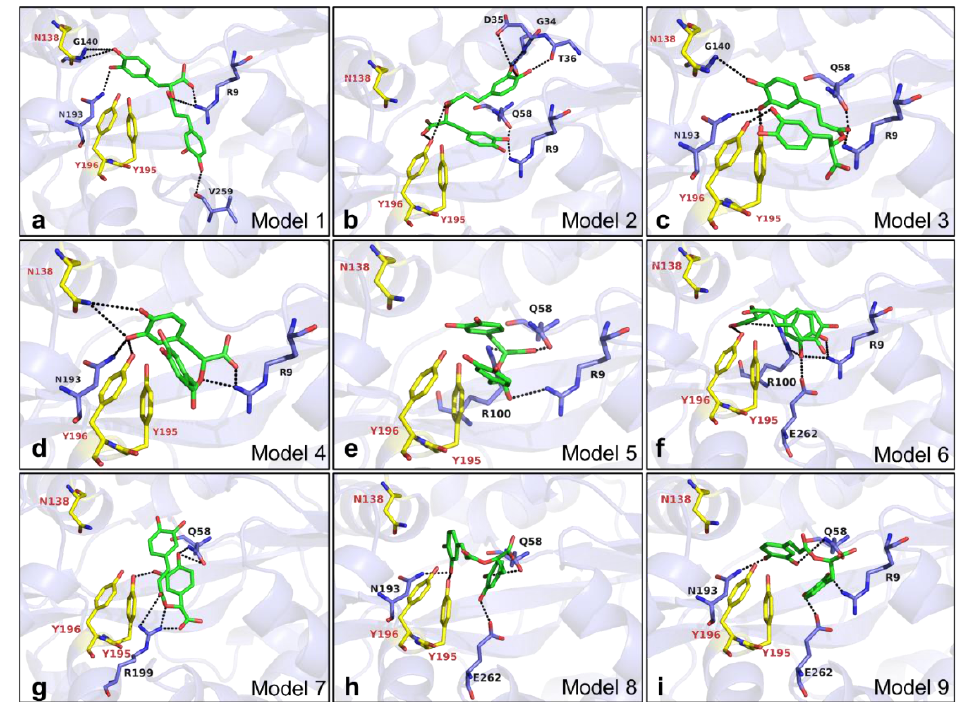
Figure 7. Docking results of RA binding to the Fe 3+ binding site of VmFbpA. ( a – i ) Docking models 1 – 9 after running docking simulation using AutoDock (version Vina 1.1.2). RA is shown as sticks in green. Fe 3+ binding site of VmFbpA (N138, Y195, and Y196) shown as sticks in yellow. The amino acid residues predicted to form hydrogen bonds toward RA are shown as sticks in purple. The hydrogen bonds predicted by PDBePISA are shown as black dashed lines. VmFbpA is shown as a cartoon with a transparency of 60% and colored in purple.